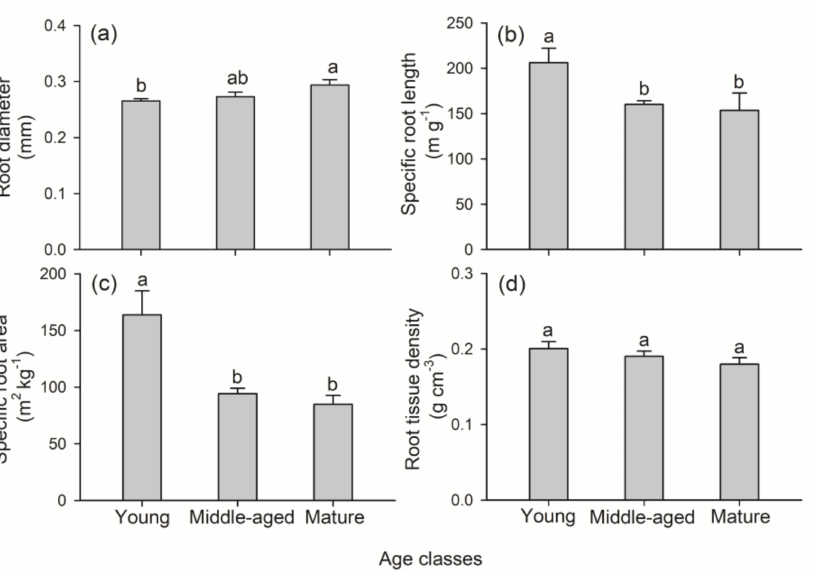
Figure 1. Root diameter (RD, ( a )), specific root length (SRL, ( b )), specific root area (SRA, ( c )), and root tissue density (RTD, ( d )) in Fraxinus mandshurica at different tree ages. Mean is shown as a bar, and SE as a whisker ( n = 5). Different lower-case letters indicate significant differences ( p < 0.05) among age classes in each